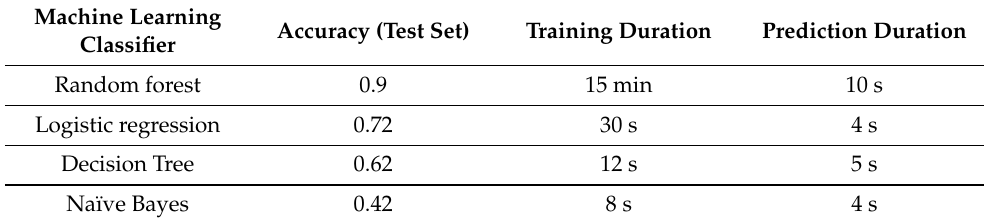
Table 8. Training and prediction durations of machine learning classifiers in the present